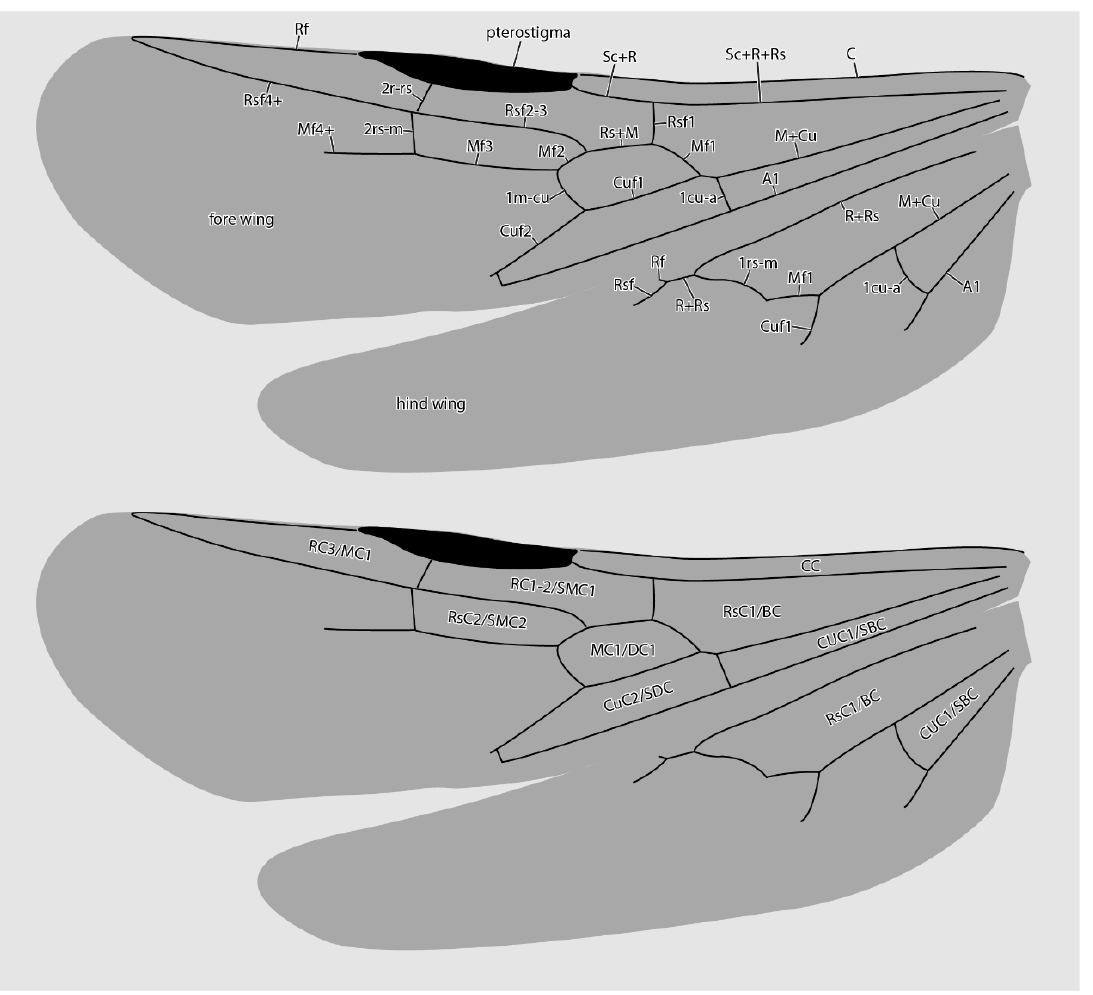
Figure 5. Diagrammatic representations of wing venation ( top ) and cell identities ( bottom ) based on the MAIG 6016 paratype 1 of † Desyopone hereon gen. et sp. nov. Cell names: CC = costal cell; RC1-2/SMC1 = first and second radial cells or submarginal cell 1; RC3/MC1 = third radial or first marginal cell; MC1/DC1 = first medial or first discal cell; RsC2/SMC2 = second sectorial or second submarginal cell; CuC1/SBC = first cubital or first subbasal cell; CuC2/SDC = second cubital or first subdiscal